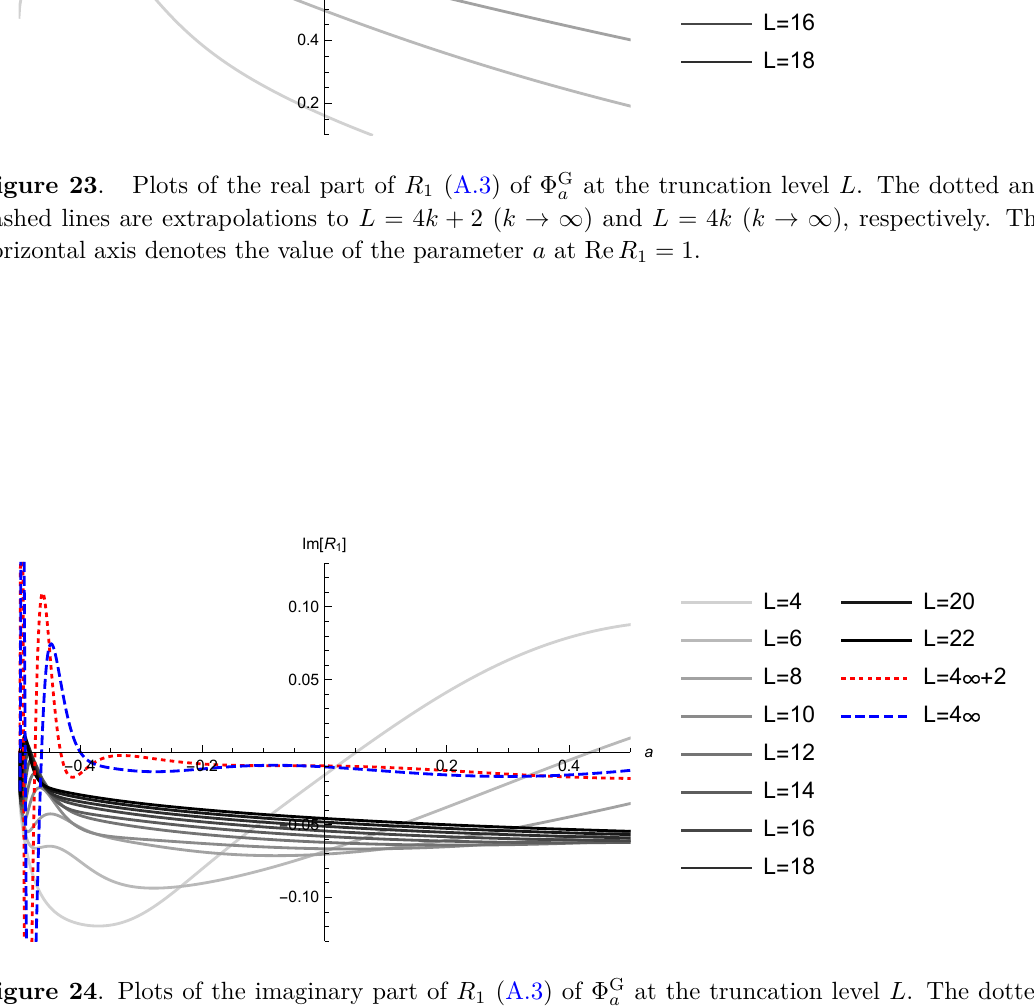
at the truncation level L . The dotted a